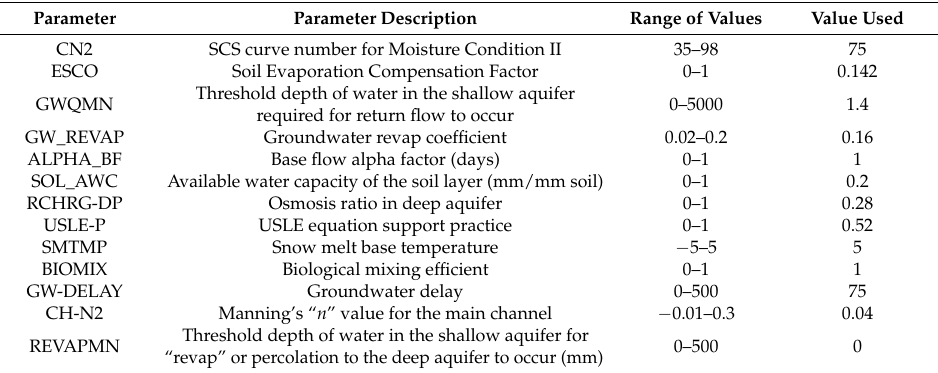
Table 1. Ranges and final values of parameters used in the SWAT model calibration. Parameter